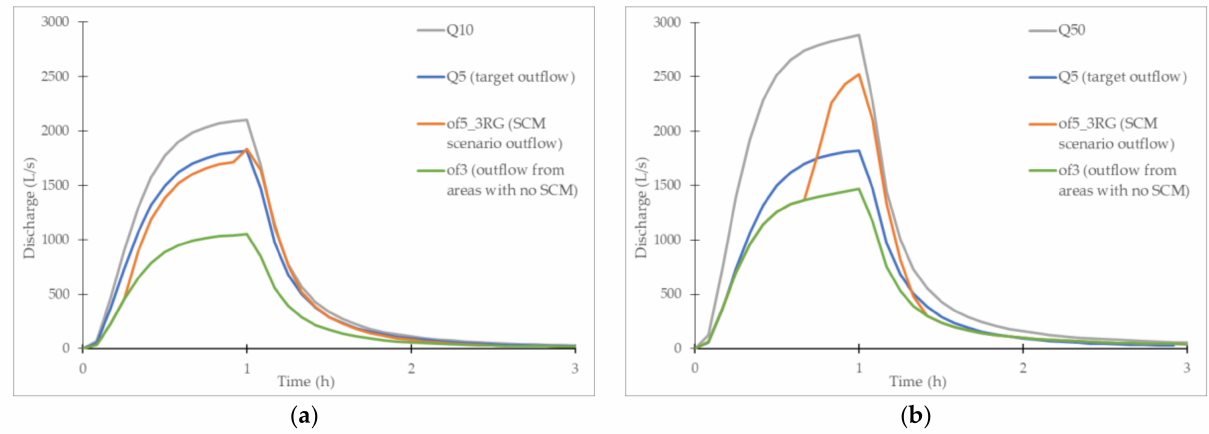
Figure 7. The results of the 3RG scenario, which includes three types of a rain garden, for DE_Q5_P10 ( a ), and DE_Q5_P50 ( b